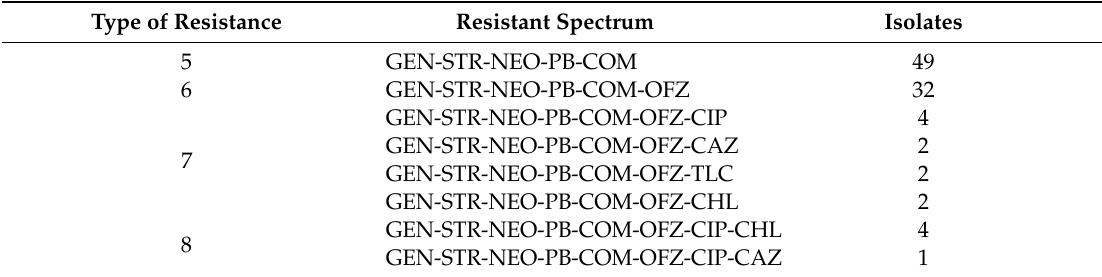
Table 2. Drug resistance spectrum of 49 strains of T. halophilus.